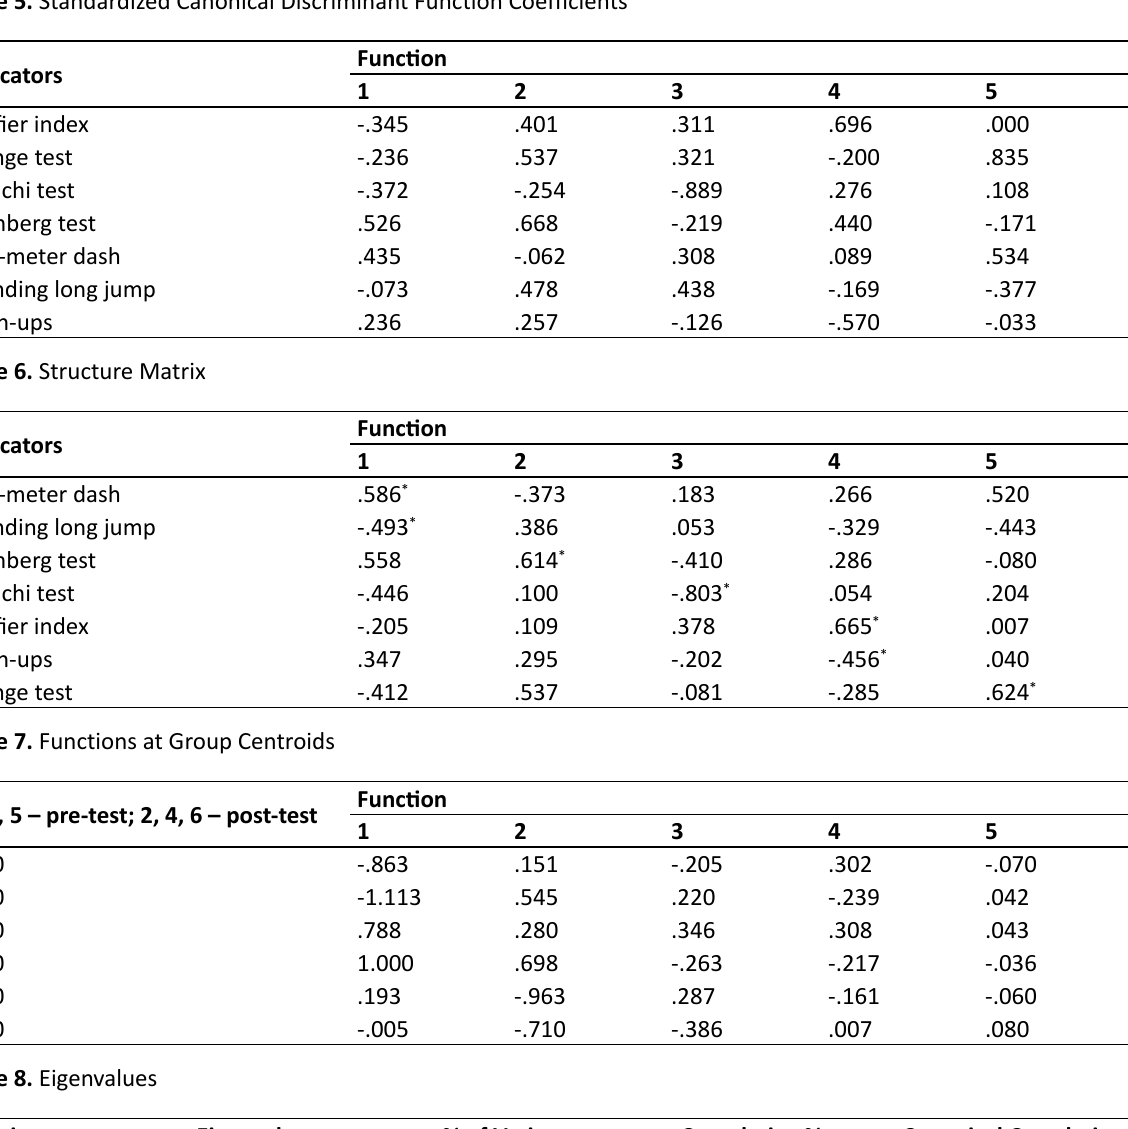
Table 5. Standardized Canonical Discriminant Function Coefficients